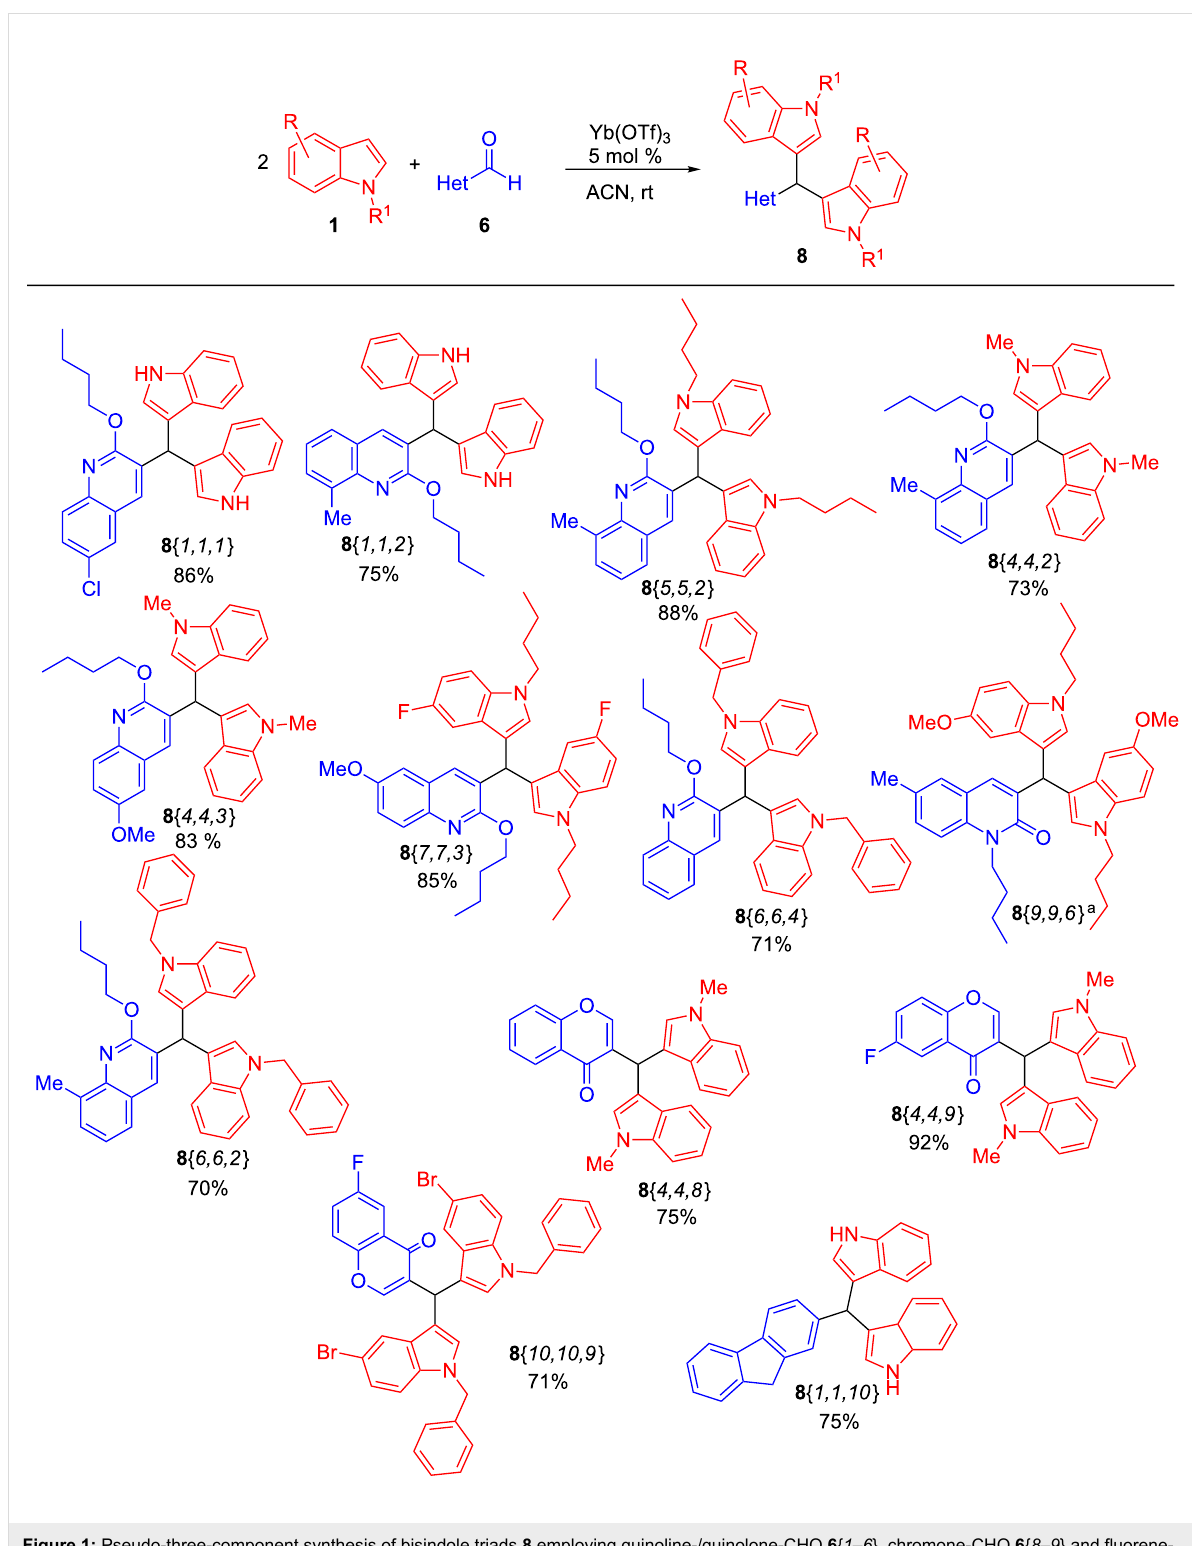
Figure 1: Pseudo-three-component synthesis of bisindole triads 8 employing quinoline-/quinolone-CHO 6 { 1–6 }, chromone-CHO 6 { 8–9 } and fluorene- CHO 6 { 10 } as coupling partners. Although entries 4 and 7 (Table 1) were satisfactory, reactions of Figure 1 were performed by following an adapta- tion of entry 3 (using Yb(OTf) 3 with a 2:1 ratio of 1 and 6 , respectively) due to lower catalyst cost (in comparison with Sc(OTf) 3 ) and/or easier work-up (in comparison with I 2 ) (see experimental section). a This product was obtained as an inseparable mixture along compound 9 { 9,6,2 } from the ap- proach described in entry 2 of Table 1 (see also Supporting Information File